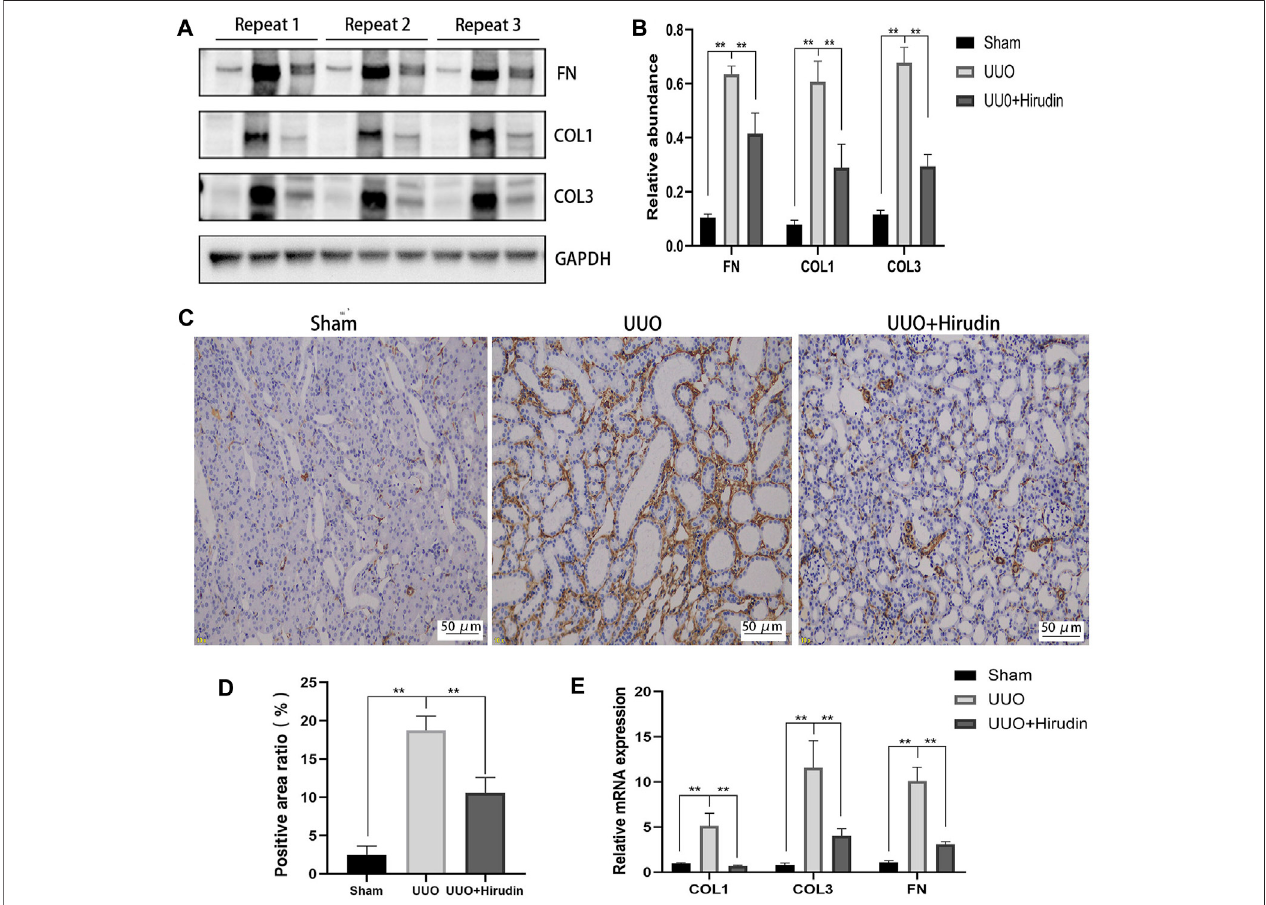
FIGURE 2 | Effect of hirudin on inhibition of FN, COL1, COL3 and α -SMA induced by unilateral ureteral obstruction (UUO). (A) Effect of hirudin on FN, COL1 and COL3 in UUO kidney tissues, as determined by Western blot. (B) Effect of hirudin on FN, COL1 and COL3 in UUO kidney tissues, according to the results of Western blot. (C) Effect of hirudin on α -SMA in UUO kidney tissues, as determined by Immunohistochemical staining (magni fi cation × 200). (D) Effect of hirudin on α -SMA in UUO kidney tissues, according to the results of Immunohistochemical staining. (E) Effect of hirudin on FN, COL1 and COL3 in UUO kidney tissues, according to the results of RT-qPCR. Data are expressed as mean ± SD for six rats per group. pp indicates p < 0.01and p indicates p < 0.05.